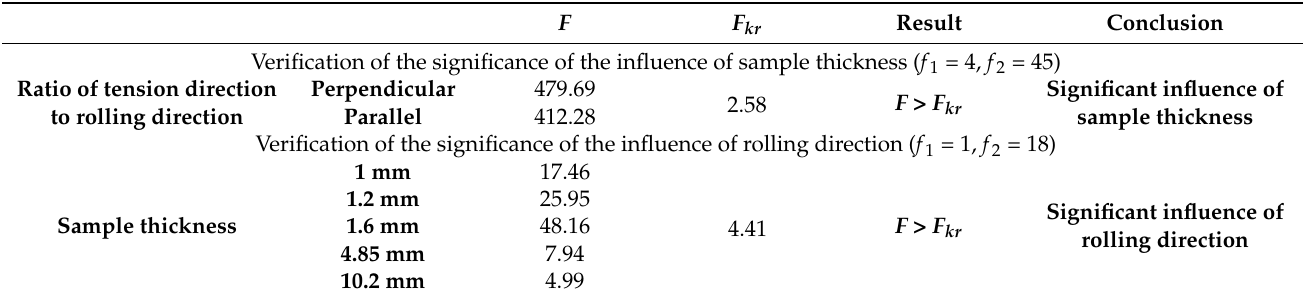
Sample thickness